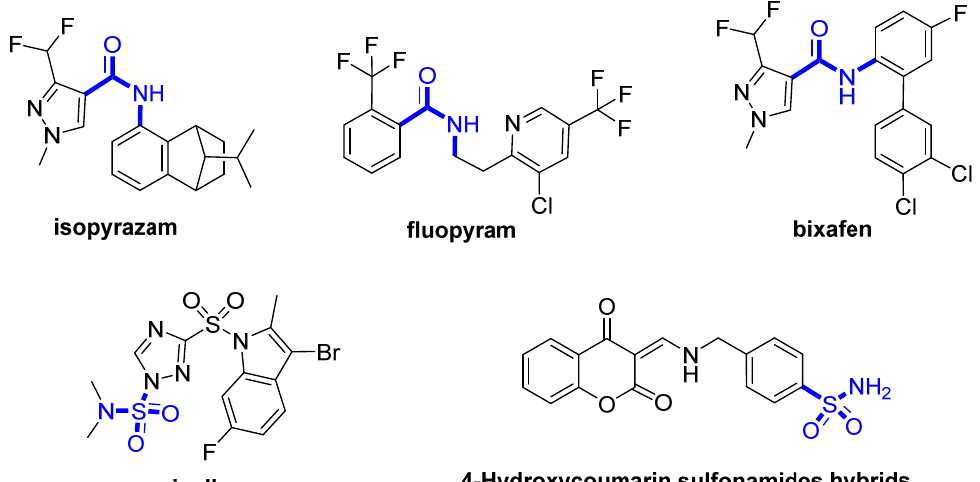
Figure 2. Representative structures of amide and sulfonamide compounds.